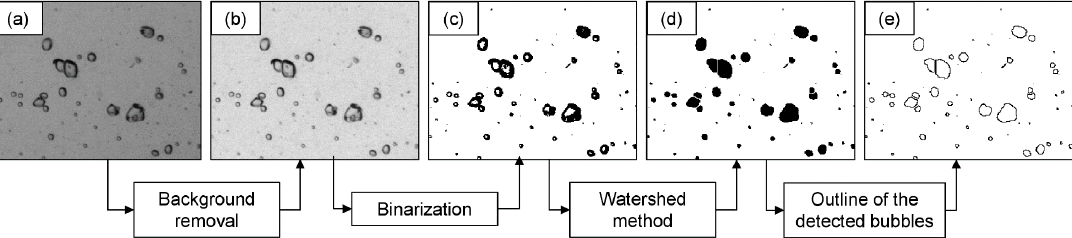
Figure 4. Steps for the boundary detection: original image ( a ); image after background removal ( b ); binary image ( c ); image after watershed operation ( d ); final image containing the outline of the detected air bubbles ( e ).